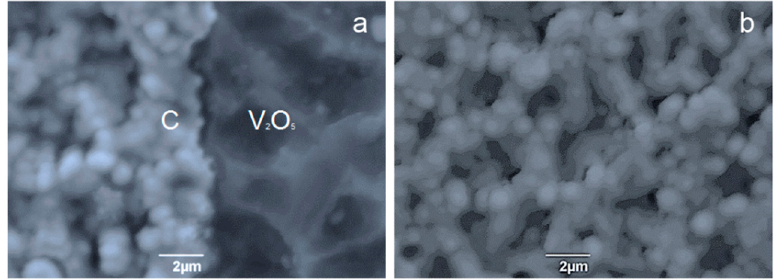
Figure 5. Morphology of the sample with V 2 O 5 /C coating: ( a ) structure of the cross-section of the multi-coating; ( b ) structure of the coating surface.